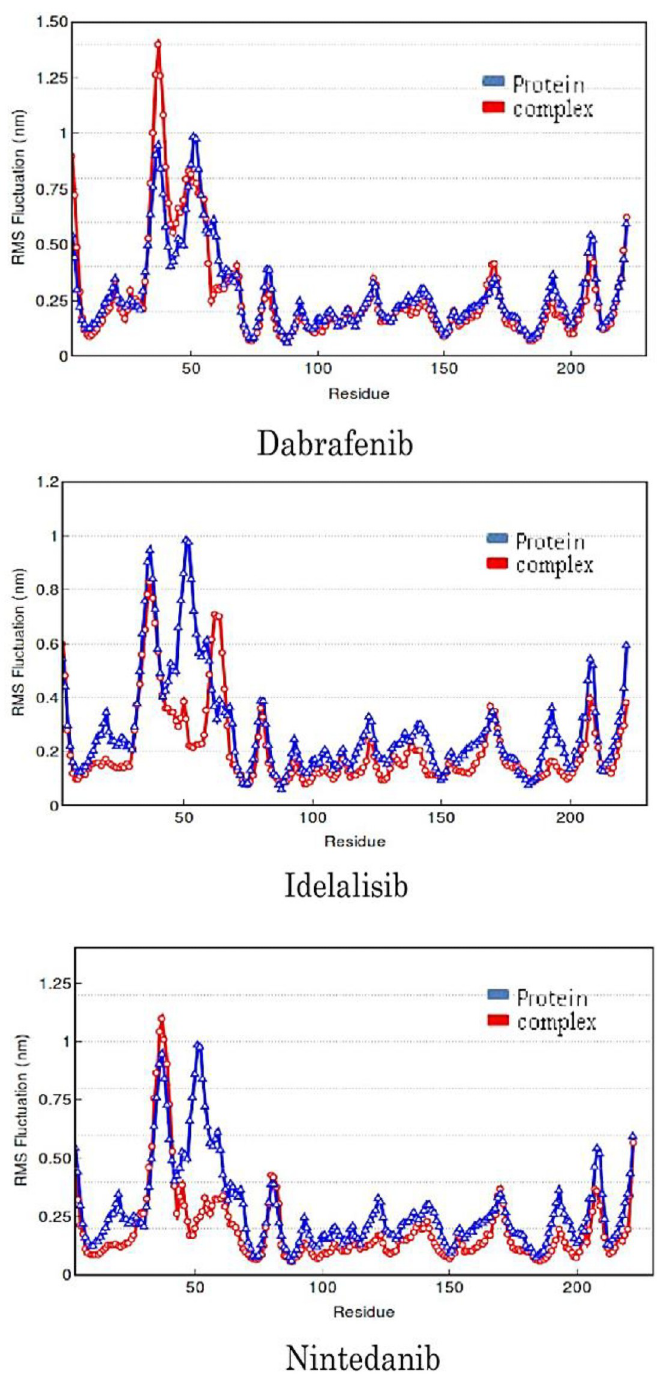
Fig 6. Residue-wise fluctuations in the type I dengue protease upon binding to the allosteric ligands.